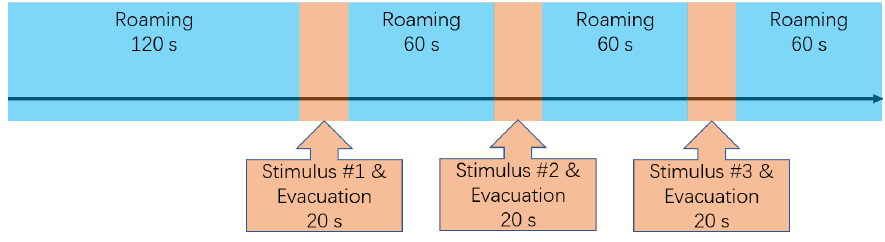
Figure 6. Procedure of simulation